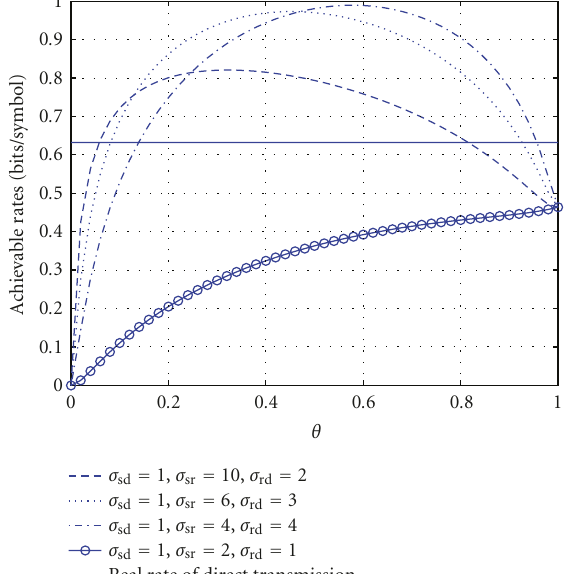
Figure 12: Nonoverlapped AF achievable rate versus θ . P = 1, and m = 50.